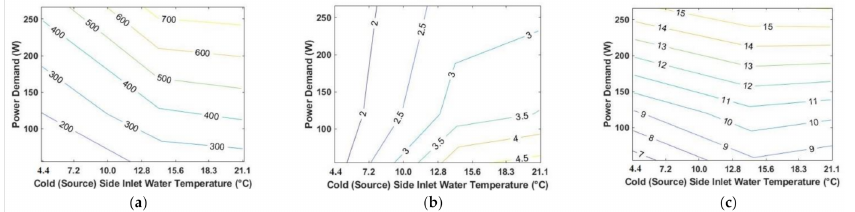
Figure 5. Heating capacities and COPs: ( a ) Heading Capacity, ( b ) Heating COPs, and ( c ) Hot Side Surface T with the hot (load) side inlet water temperature of around 4.4 ◦ C (3.9~4.7 ◦ C); ( d ) Heading Capacity, ( e ) Heating COPs, and ( f ) Hot Side Surface T with the hot (load) side inlet water temperature of around 21.1 ◦ C (20.9~21.4 ◦ C).